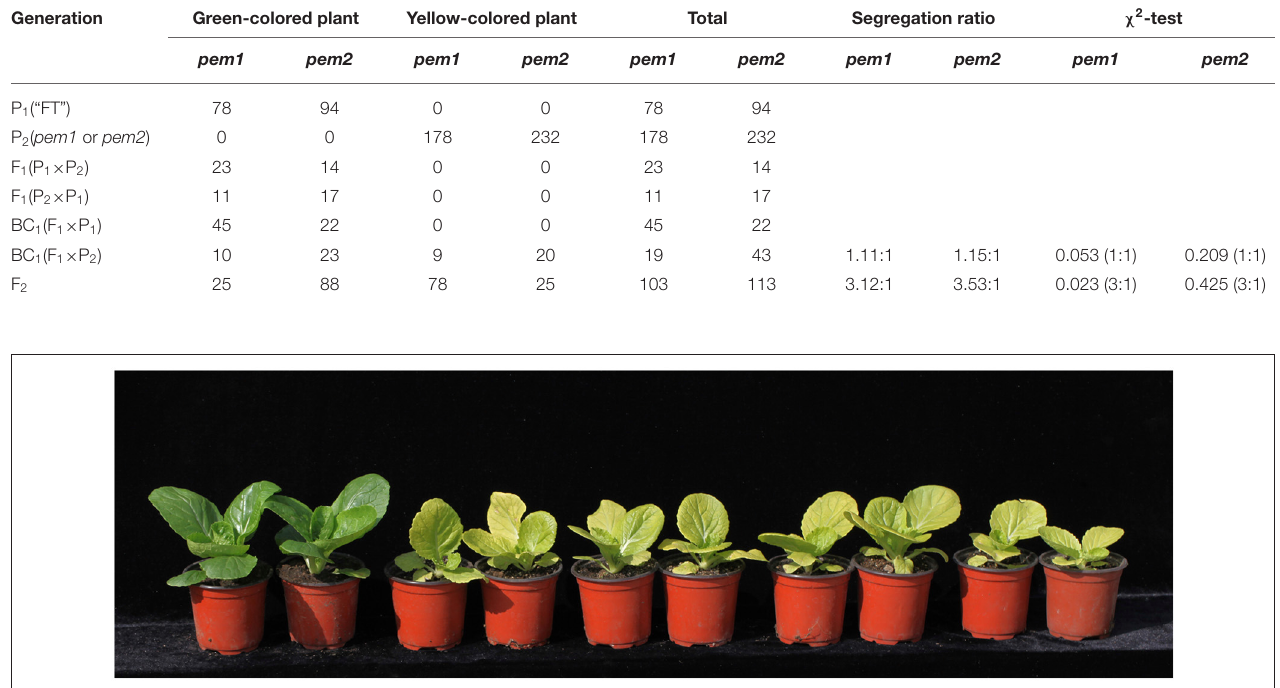
mutation phenotype of pem1 was controlled by a single nuclear recessive gene. Table 2 also shows the population phenotype of pem2 . The results indicate that the pale green phenotype of pem2 was caused by the recessive mutation of a single nuclear